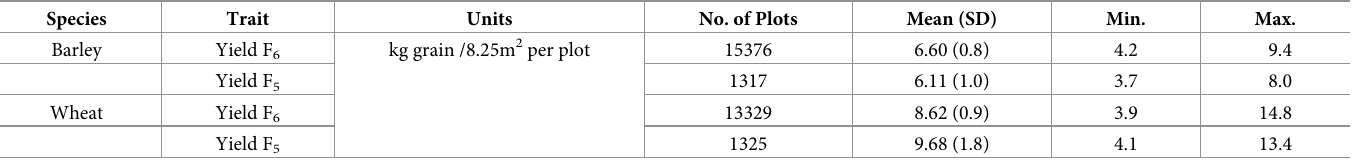
Table 1. Descriptive statistics for spring barley and winter wheat phenotypic